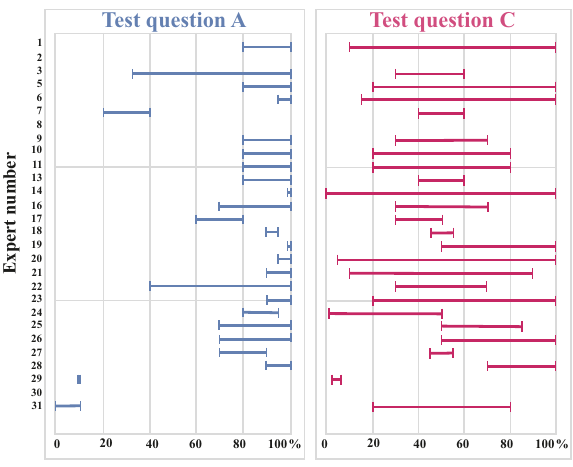
Figure 3: Degree of (un-)certainty required to provide “no/unsure” answers to the question “Will there be an eruption by